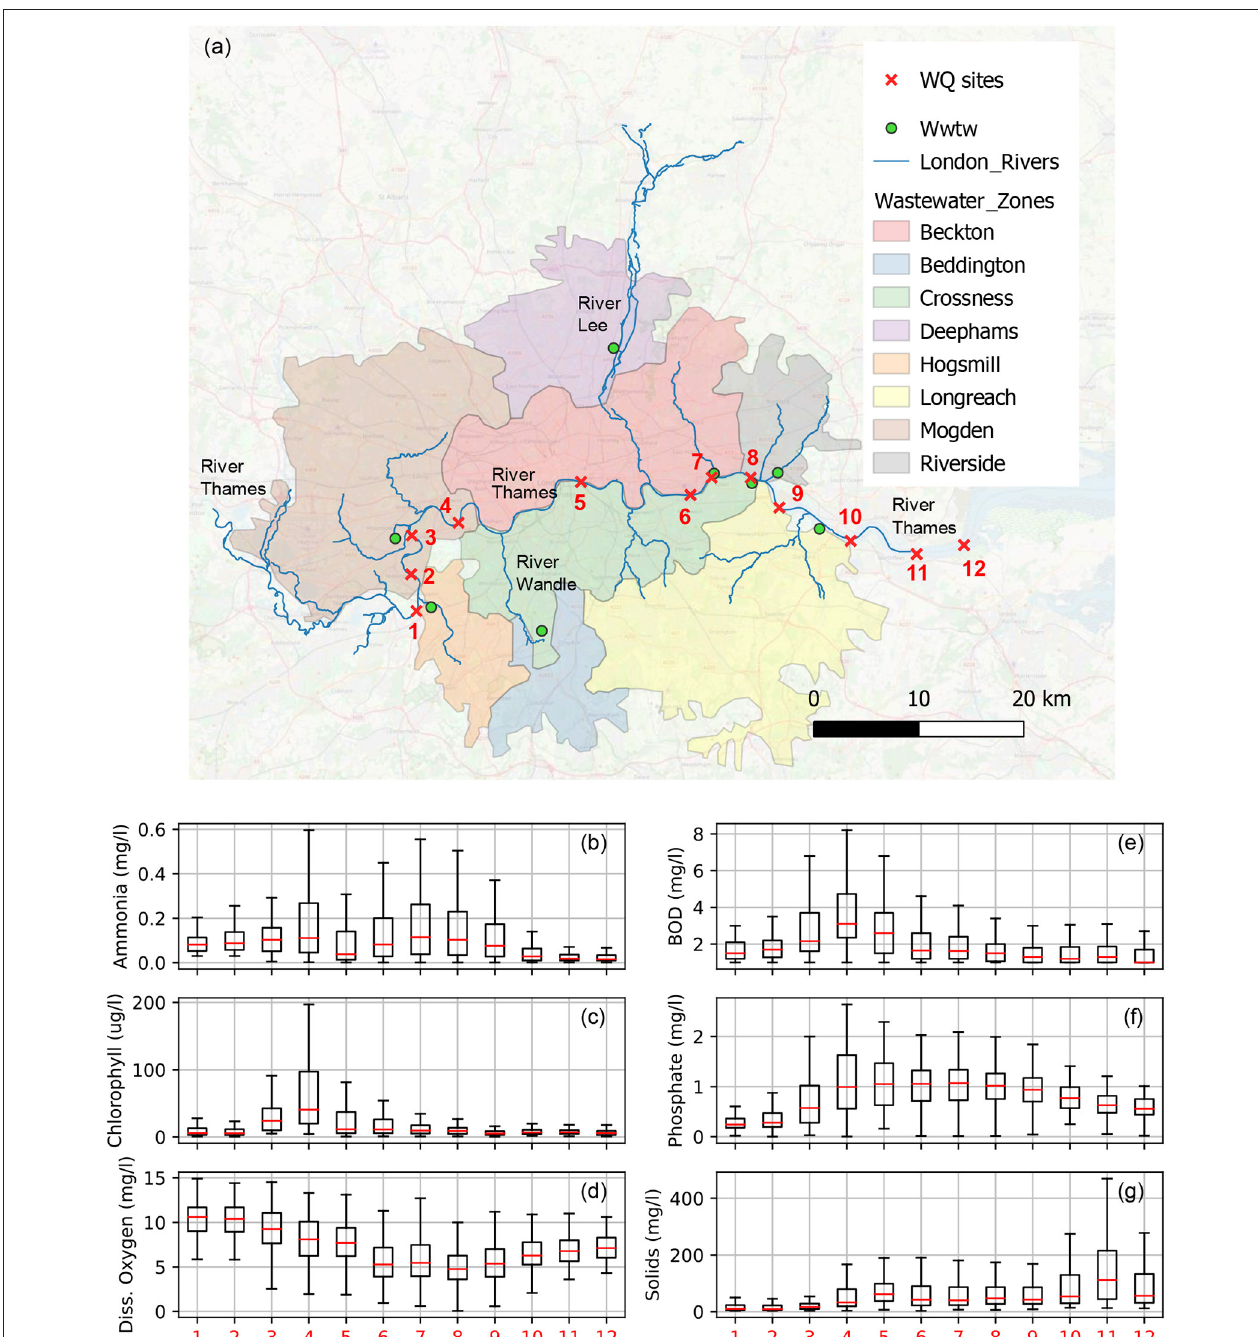
FIGURE 1 | (a) Map depicting London and the eight wastewater zones and treatment plants (WWTW) of the city, key water quality (WQ) sites along the lower River Thames are indicated with red crosses. (b–g) Boxplots displaying distribution of the most commonly sampled pollutants’ concentrations at the key WQ sites. Samples come from the WIMS database from 2000 to 2020 (Environment Agency, 2020), red bars indicate the median sample value, boxes the interquartile range (IQR) and whiskers indicate the range of measurements that are ± IQR*1.5 within the upper and lower quartiles. Measurements that fall outside of the whiskers are not shown to improve the readability of